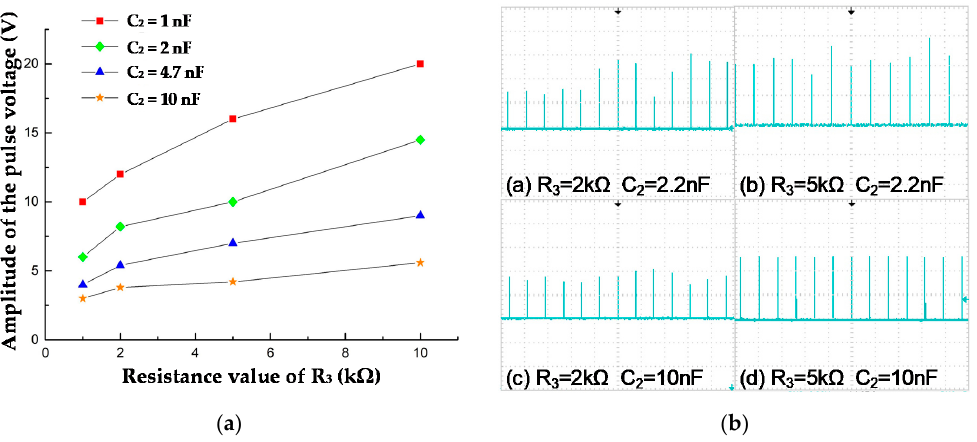
Figure 7. The output pulses under different RC parameters. U w = 350 V. ( a ) Impulse voltage amplitude under different RC parameters. ( b ) Impulse waveform under different RC parameters.